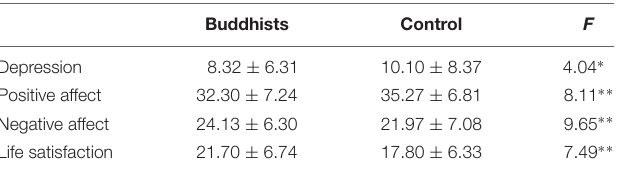
TABLE 3 | Comparisons between the Buddhist and control groups on psychological adjustment.